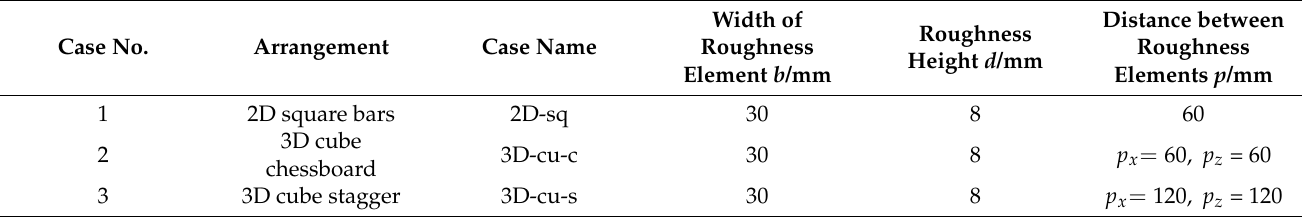
Table 1. Configuration of roughness